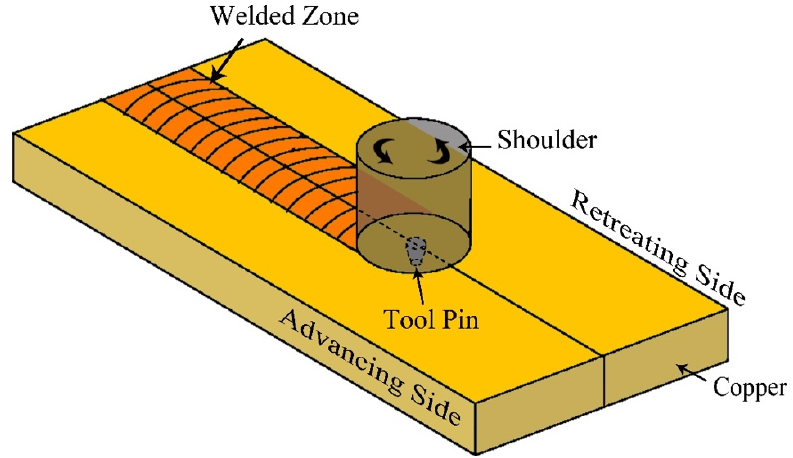
Figure 1. Schematic of friction stir welding process.